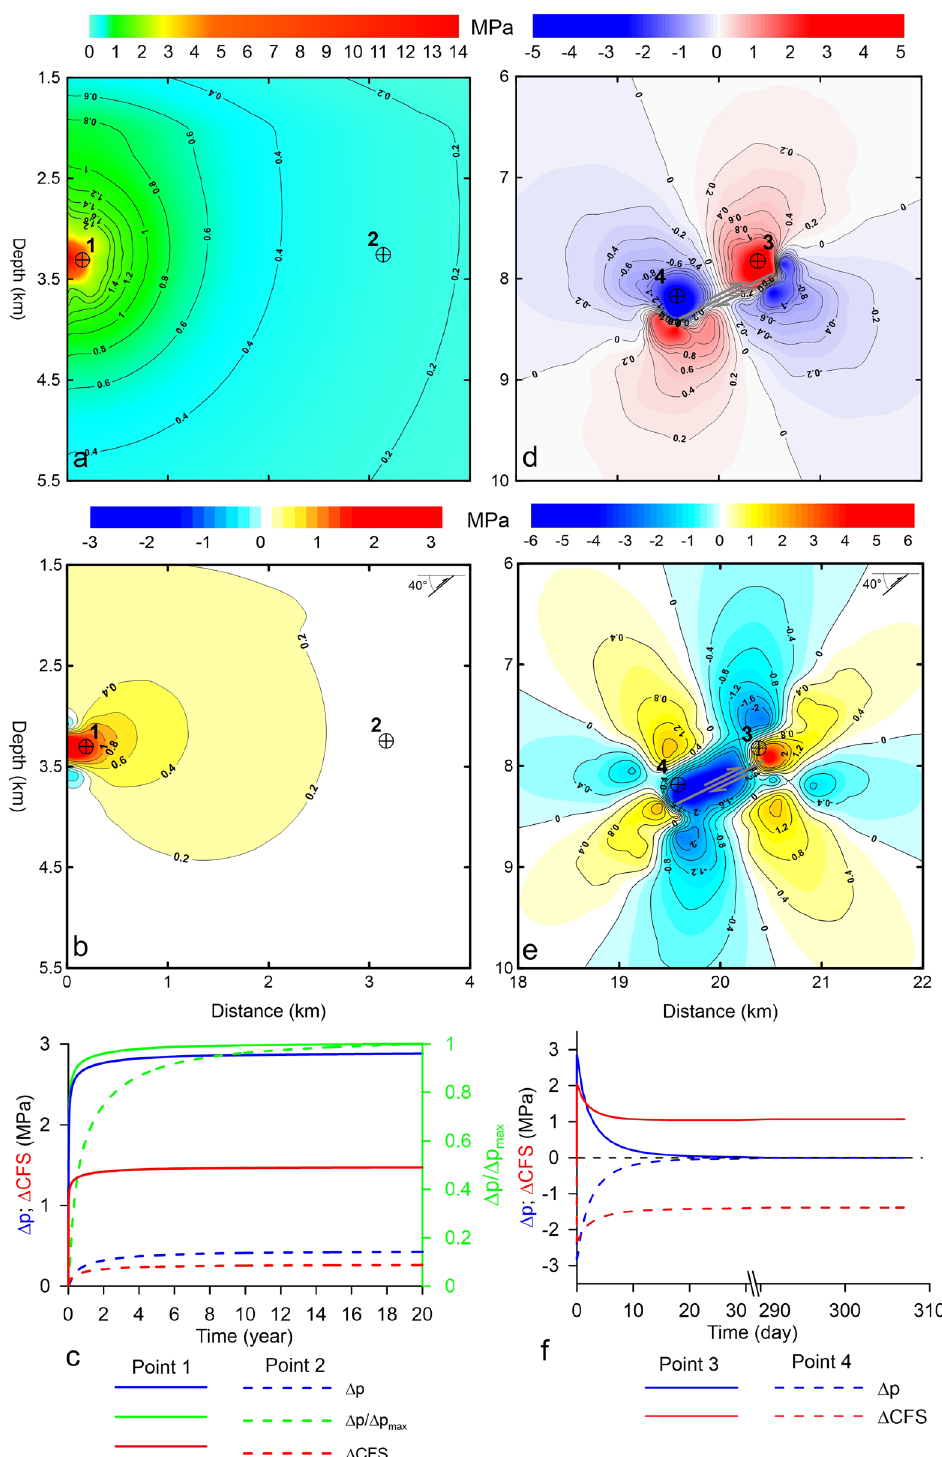
Figure 3. ( a ) Fluid overpressures after 20 years of injection at the Cavone 14 well (DIFF model; panel b in Fig. 2). ( b ) Coulomb stress changes after 20 years of injection at the Cavone 14 well. ( c ) Temporal evolution of the overpressures ( Δ p), overpressure ratio ( Δ p / Δ pmax ) and Δ CFS at points 1 and 2 in panels a and b. ( d ) Coseismic fluid overpressures and underpressures immediately after the simulated Mw 4.5 earthquake (EQK model; panel c in Fig. 2). ( e ) Coulomb stress changes ten months after the July 17, 2011 Mw 4.5 earthquake. ( f ) Temporal evolution of the overpressures ( Δ p) and Δ CFS at points 3 and 4 in panels d and e. The figures were created with Surfer ® and Grapher ® from Golden Software, LLC (www.goldensoftware.com). For context, the relative positions of the blown-up illustrations in ( a ), ( b ), ( d ) and ( e ) from Figs 3 and 4 are given in Supplementary Figures